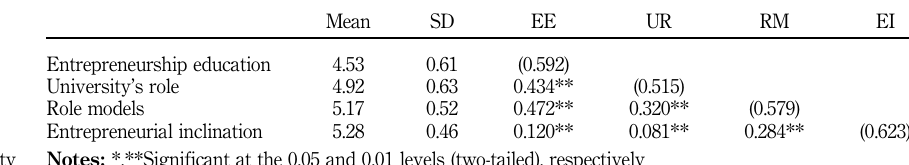
Table III. Goodness-of-fit results for entrepreneurship